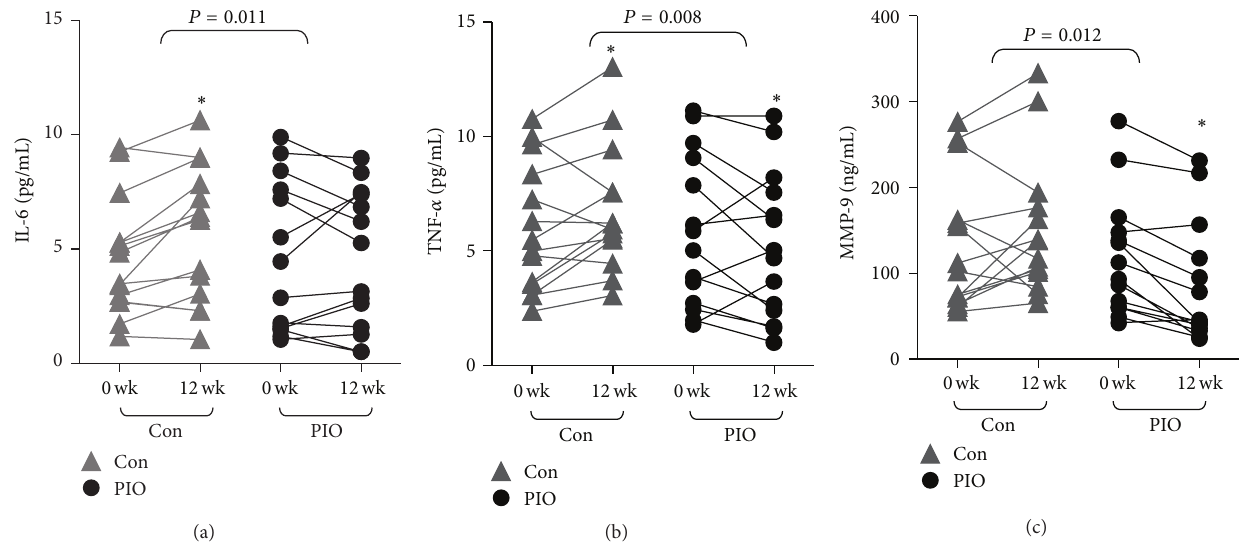
Figure 1: Pioglitazone decreased plasma proinflammatory factors concentrations in patients after coronary DES implantation. The results are presented as raw data. Compared to the control group, PIO significantly reduced plasma IL-6, TNF- 𝛼 , and MMP-9 concentrations by TWRMANOVA ( 𝑃 = 0.011 , 0.008, 0.002, and 0.012, resp.). ∗ 𝑃 < 0.05 compared with